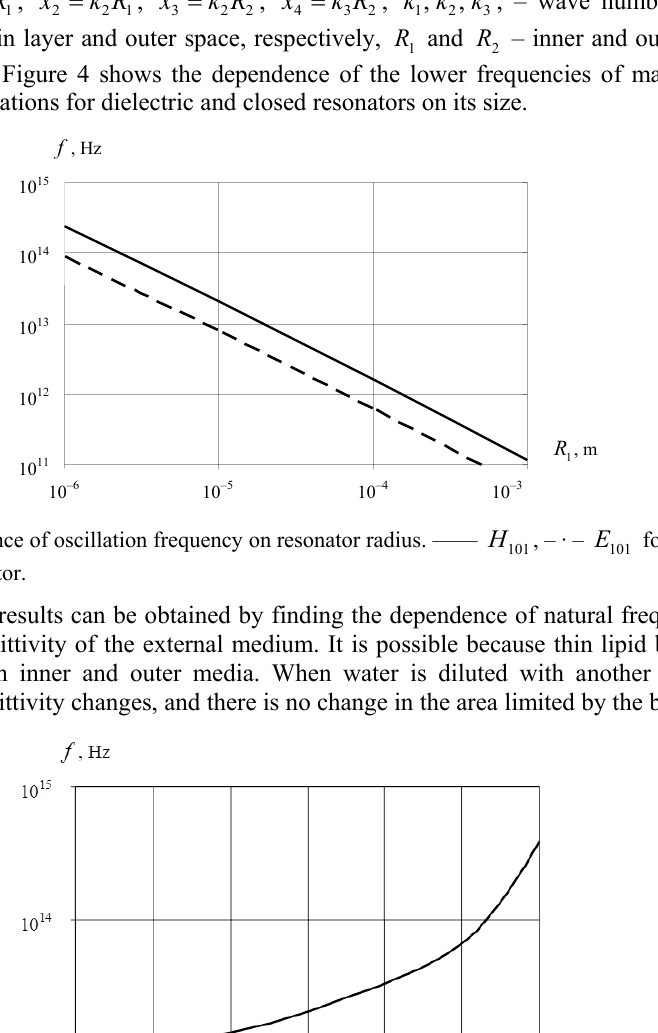
Fig. 5. Frequency dependence of oscillation on the dielectric constant of the external